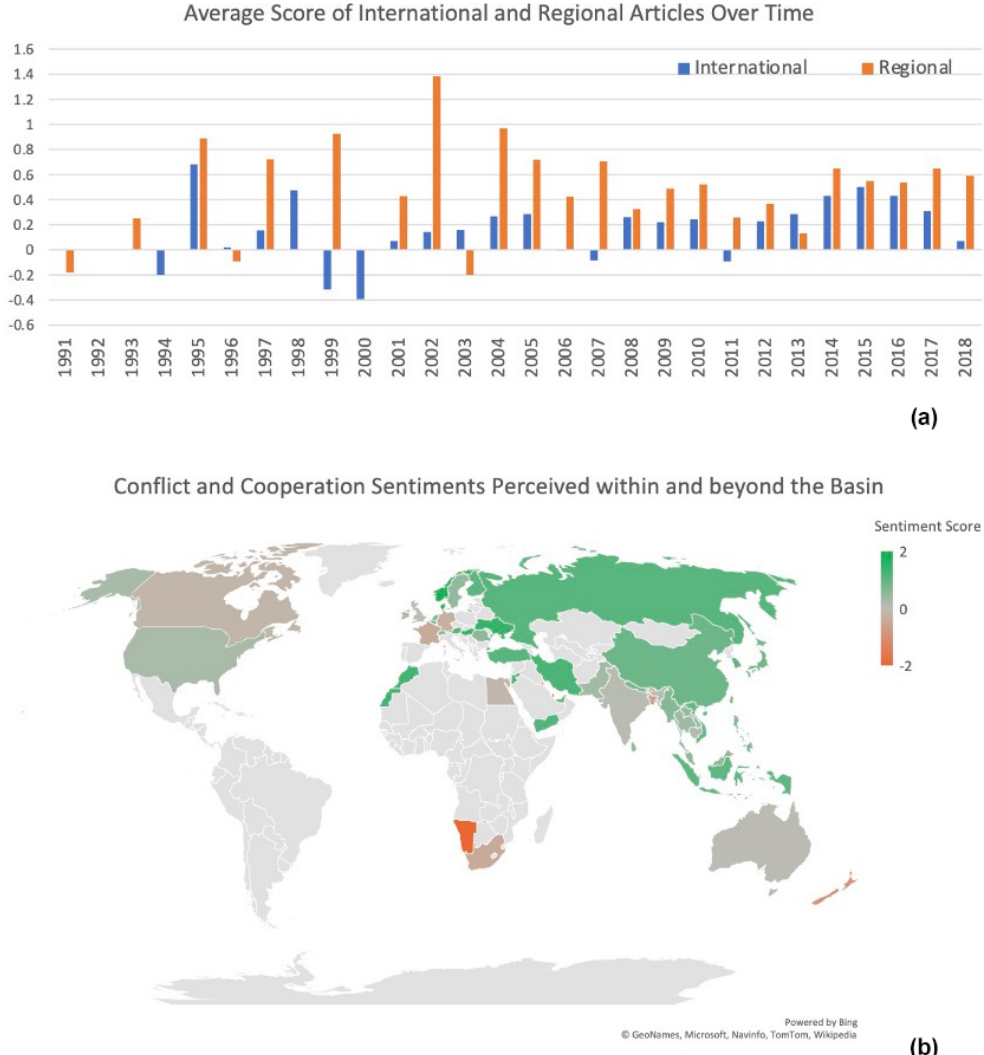
Figure 6. The average sentiment score of regional and international newspapers from 1991 to 2018 (a) . Conflict and cooperation sentiments perceived within and beyond the basin (b)